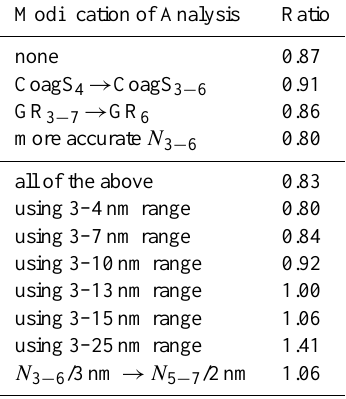
Table 1. Sensitivity of the ratio of formation rates (Eq. (3)/Eq. (5), calculated as a mean of values during 11:00–13:00) to differ- ent parameters affecting new particle formation. Nomenclature: BKG=background particle concentration, A =activation coefficient, bins=number of size sections.